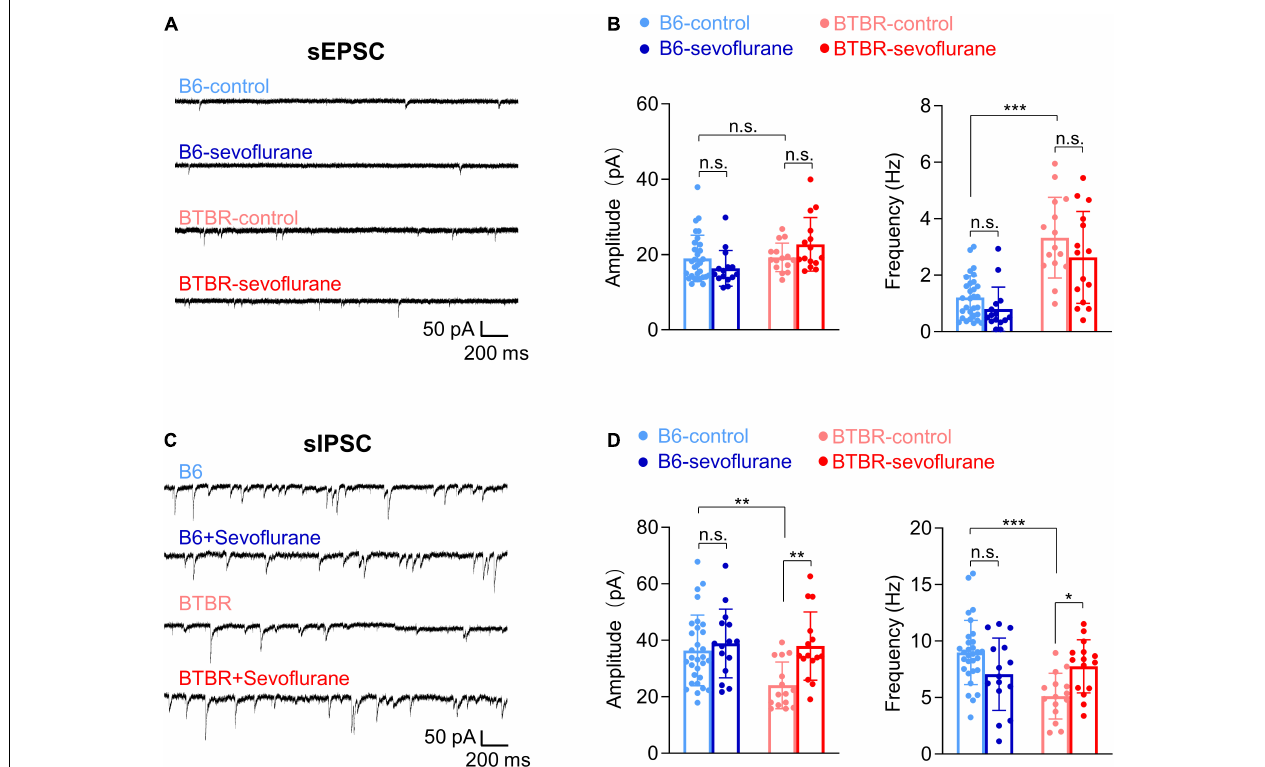
FIGURE 1 | Sevoflurane exposures induce excitatory/inhibitory imbalance in late postnatal BTBR mice. Postsynaptic currents were measured in pyramidal neurons (mPFC layer II, III) 5 days after mice received three episodes of sevoflurane exposure at 2-h intervals. (A) Examples of sEPSCs. (B) Quantification of sEPSC amplitude (pA) and frequency (Hz) (B6-control, n = 30 cells from seven mice; B6-sevoflurane, n = 15 cells from three mice; BTBR-control, n = 15 cells from four mice; BTBR-sevoflurane, n = 15 cells from three mice). (C) Examples of sIPSCs. (D) Quantification of sIPSC amplitude (pA) and frequency (Hz) (B6-control, n = 30 cells from seven mice; B6-sevoflurane, n = 15 cells from three mice; BTBR-control, n = 15 cells from four mice; BTBR-sevoflurane, n = 15 cells from three mice). Values are presented as means ± SD (* p < 0.05, ** p < 0.01, *** p < 0.001, n.s., not